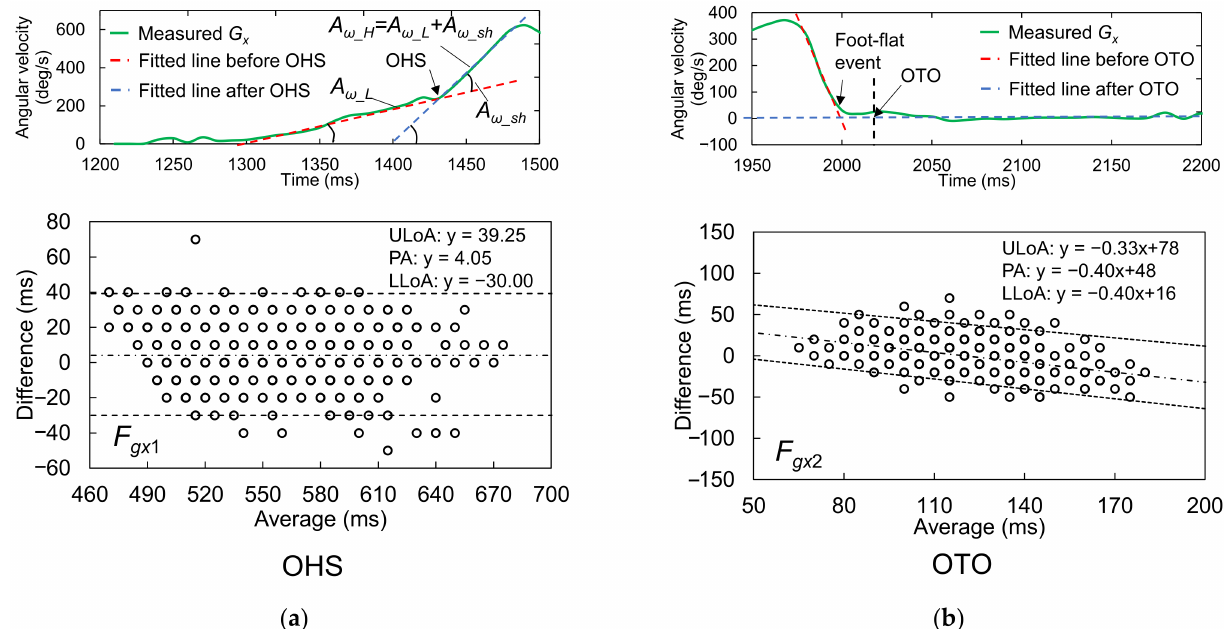
Figure 10. Detailed characteristics and Bland–Altman plots of the best candidates for ( a ) OHS and ( b ) OTO detection. The upper and lower LoAs (ULoA and LLoA, black dotted lines) are shown around the PA (black dashed line) for comparison of the IMS and Vicon gait event detection results. The LoAs for OTO were corrected by a nonparametric approach via quantile